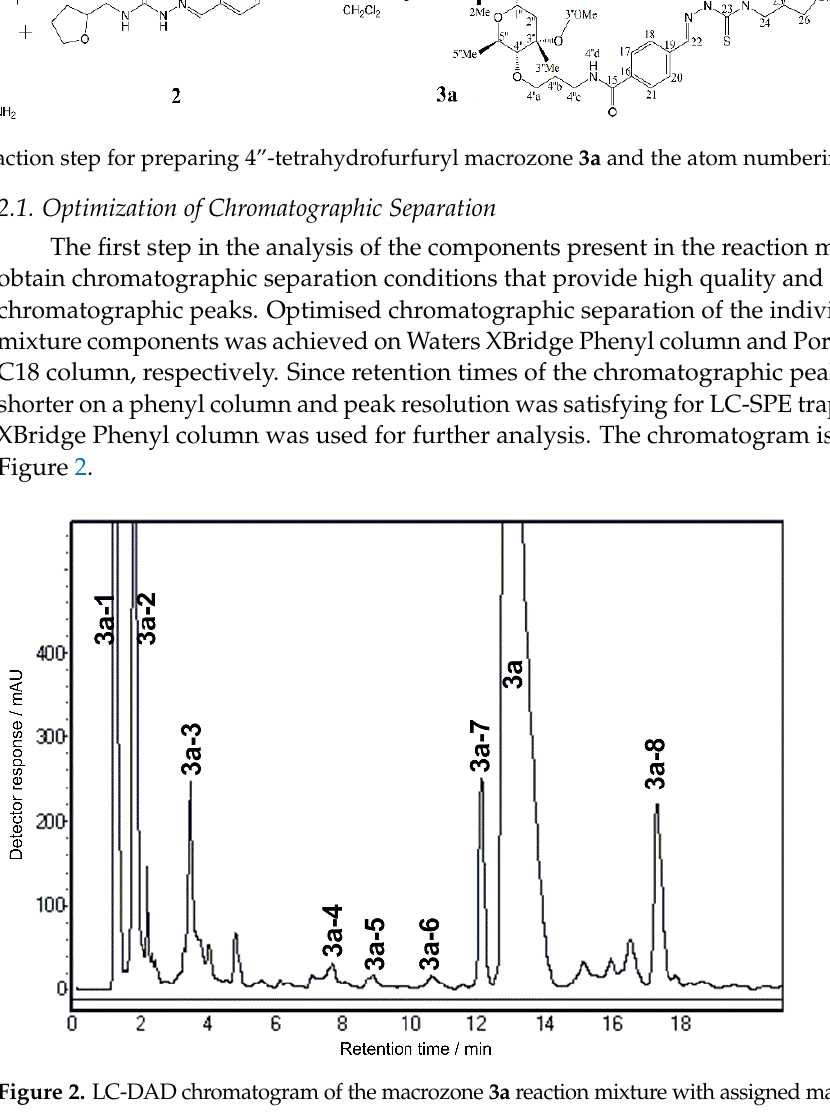
Figure 1. The final reaction step for preparing 4 ″ -tetrahydrofurfuryl macrozone 3a and the atom numbering.